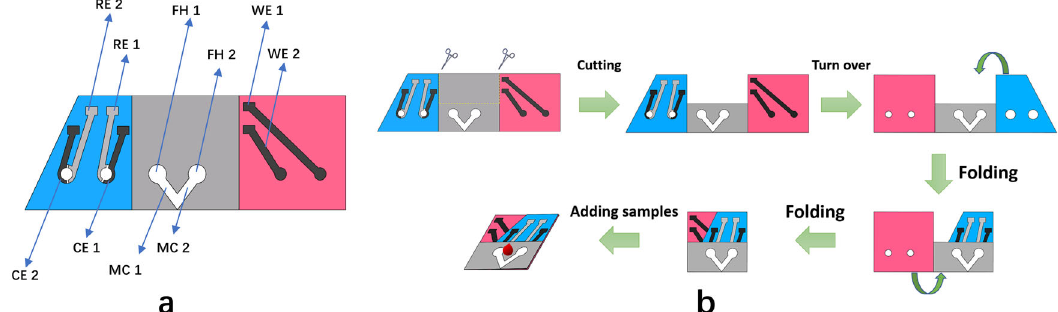
Fig. 7 Structure and fabrication of the origami paper-based device. a Display for each functional area, including working electrodes (WE 1 and WE 2), counter electrodes (CE 1 and CE 2), reference electrodes (RE 1 and RE 2), micro fl uidic channels (MC 1 and MC 2), and fi lter holes (FH 1 and FH 2). b The folding process of the device. Cut along the dotted line and fold the paper-based device as shown in the picture to get an available device.